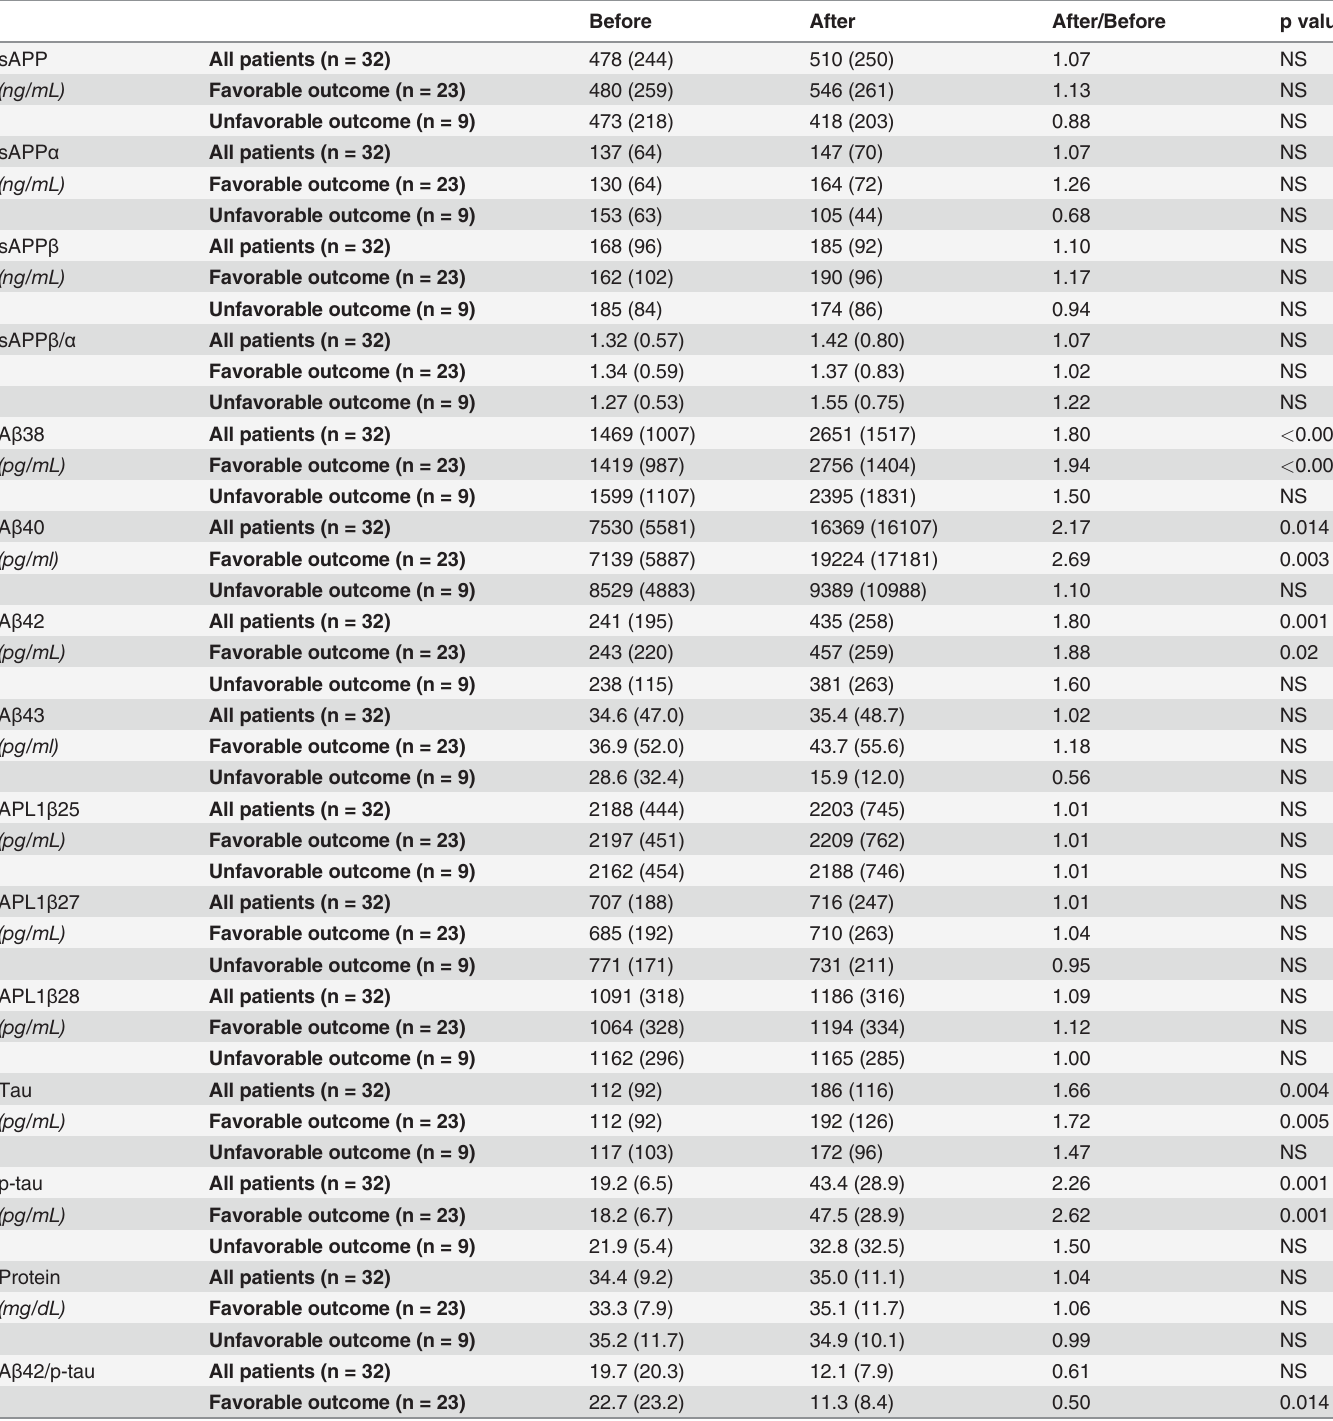
Table 3. Comparison of CSF values in patients with iNPH before and 1 year after LPS. Before After After/Before p